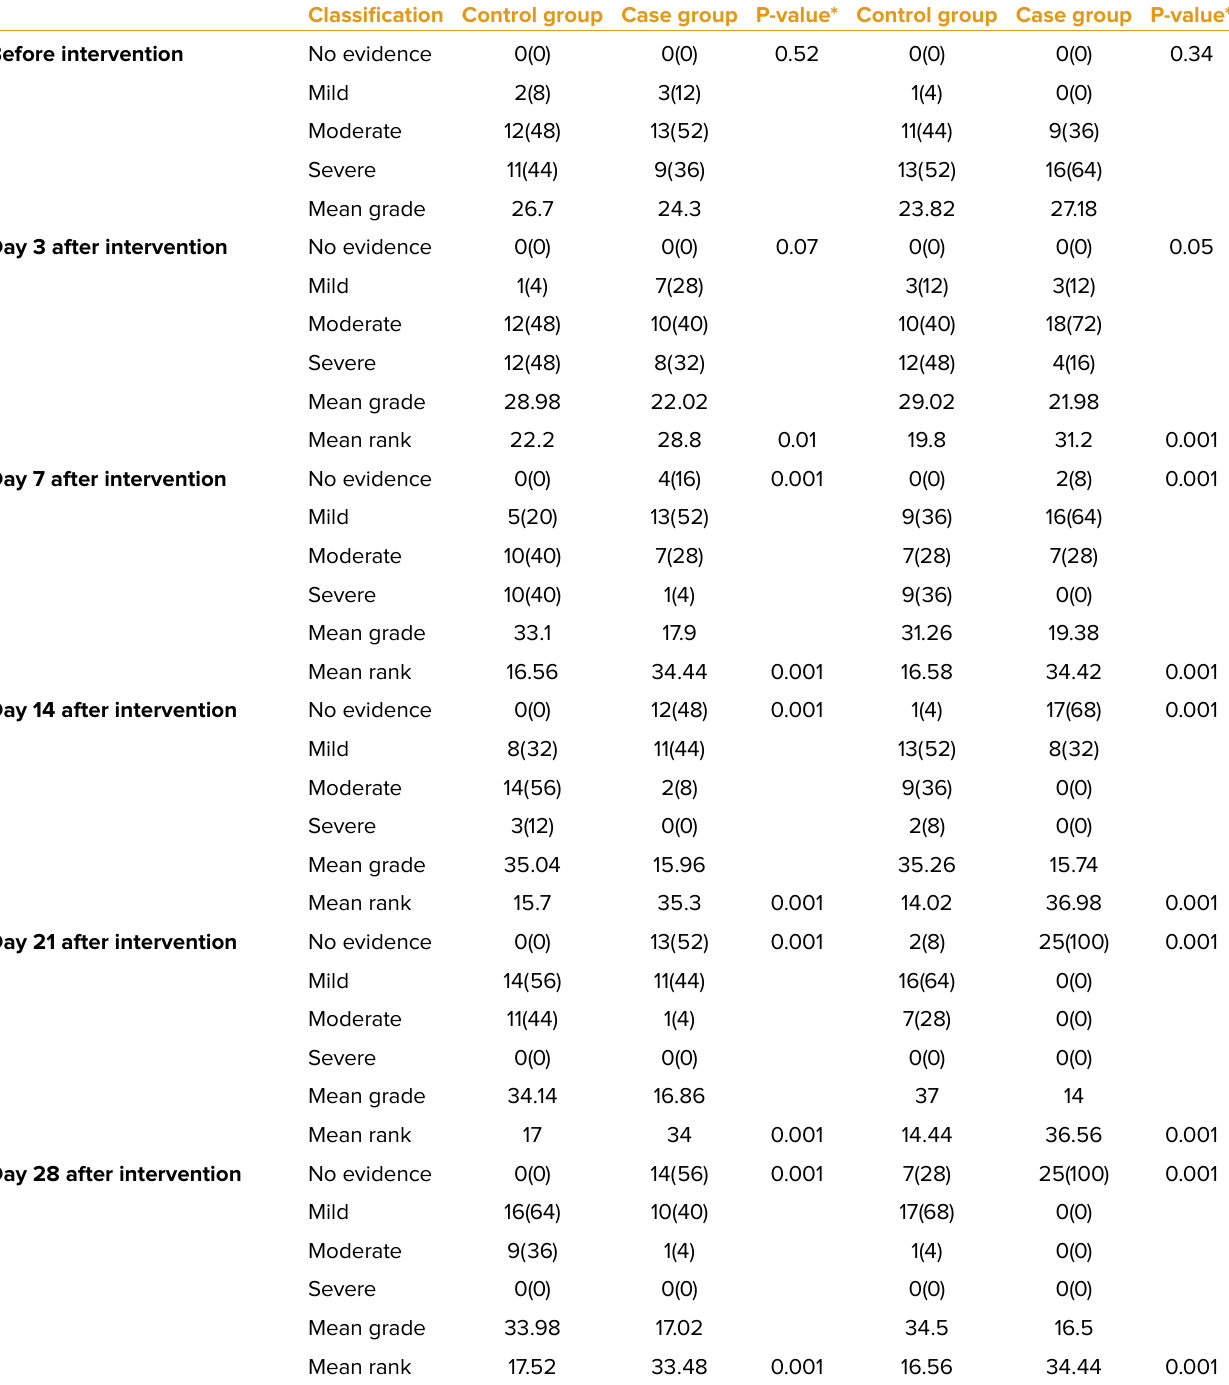
Table 4. Comparison of the corneal haziness and edema at the baseline, 3, 7, 14, 21, and 28 days after the intervention between the groups Intervals Corneal haziness, No. (%) Corneal edema, No.